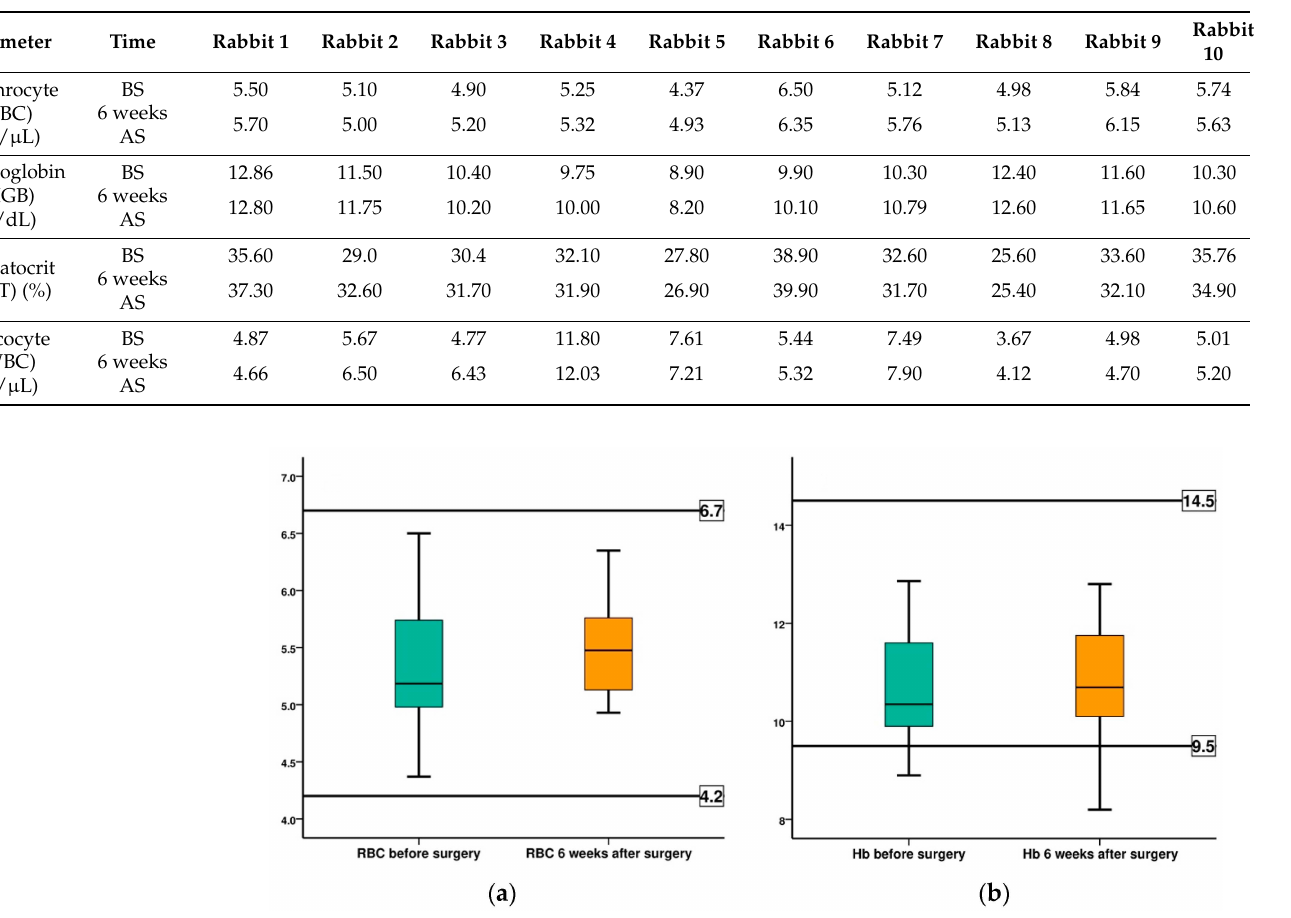
Figure 16. Comparison of the evolution of red blood cells (RBS) and hemoglobin (Hb), in both groups, before surgery (BS) and at 6 weeks after surgery (AS): ( a ) RBC count; ( b )